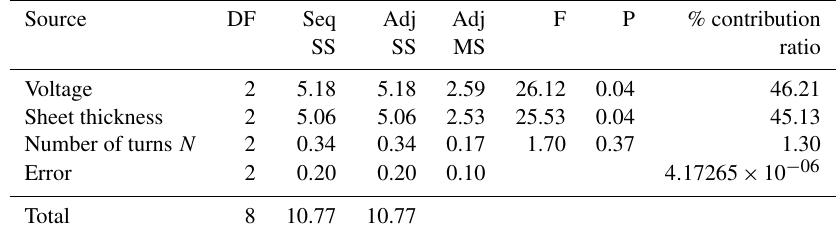
Table 7. Analysis of variance of Z displacement for the three parameters used in this study. Source DF Seq